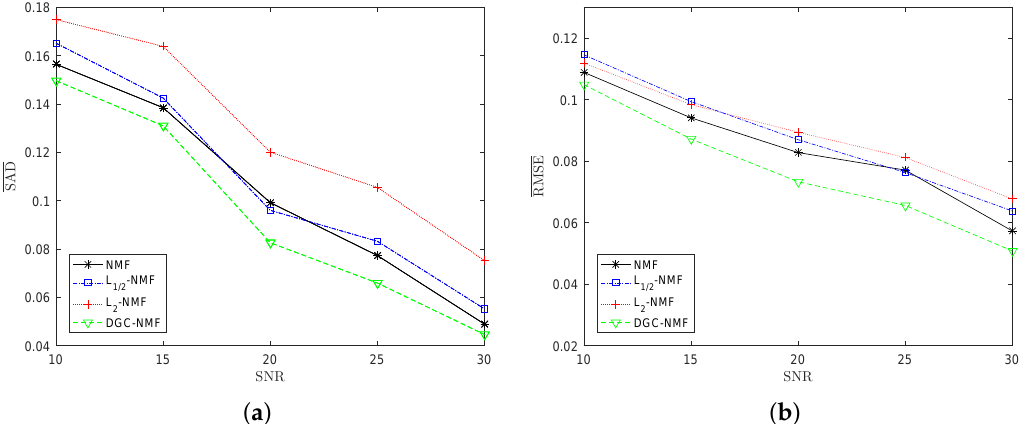
Figure 10. Performance comparison of the algorithms under various noise levels. ( a ) SAD; ( b )